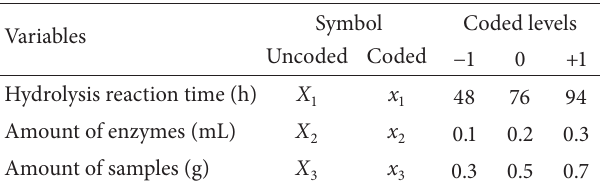
Table 1: Levels and code of variables chosen for Box-Behnken design.